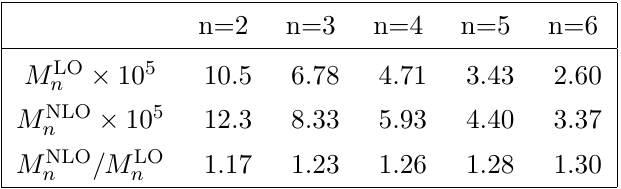
( z, µ F ) with µ F = 3 m c and c